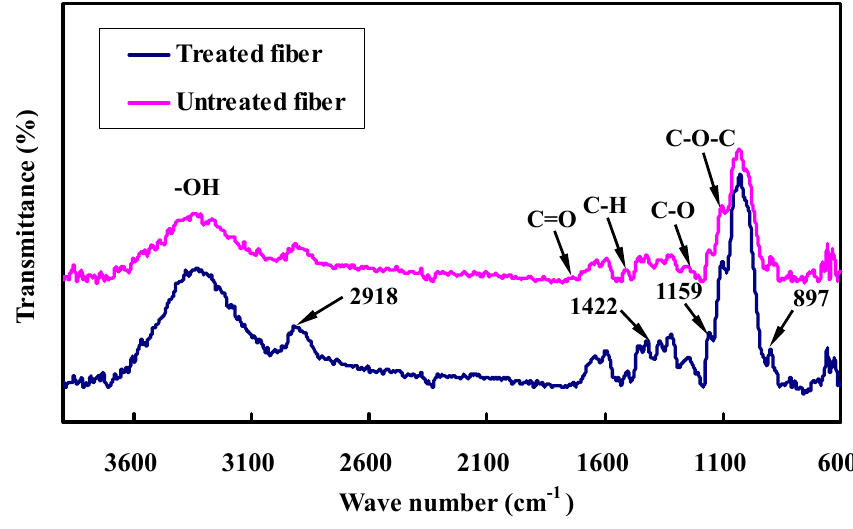
Figure 4. FTIR spectra of untreated and alkali treated fibers. Table 1. Infrared transmittance peaks of fiber constituents.